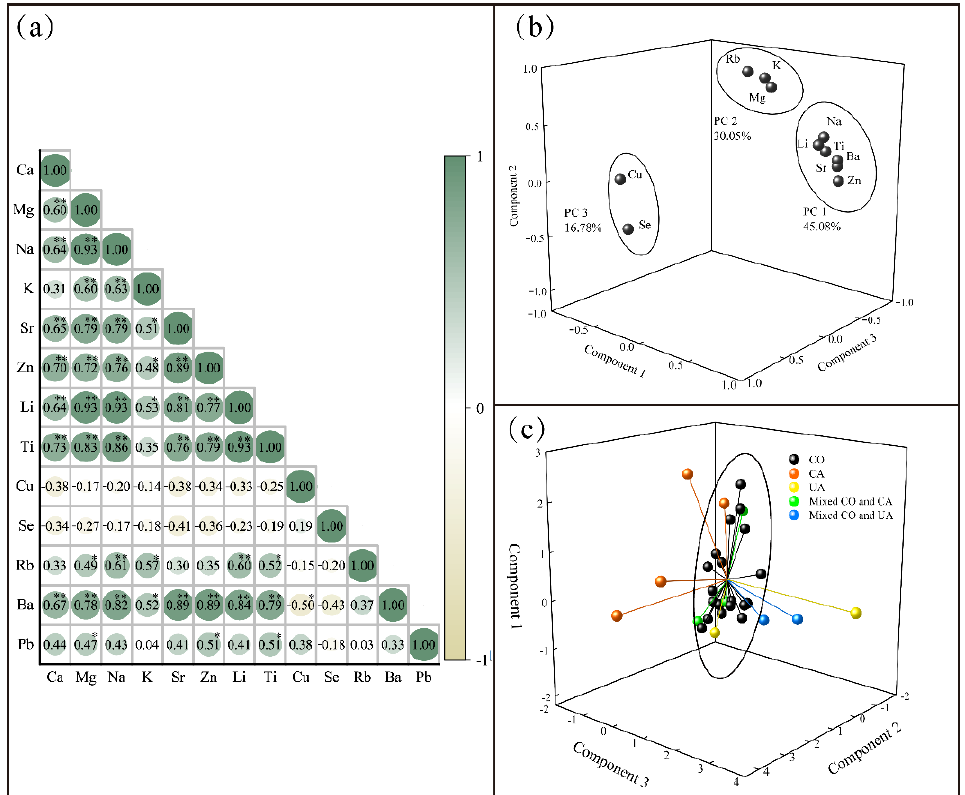
Figure 2. ( a ) correlation analysis in calcium oxalate stones; ( b ) principal component analysis of ele ‐ ments in kidney stones, and ( c ) scores of kidney stones in principal components. ** p < 0.01; * p < 0.05.